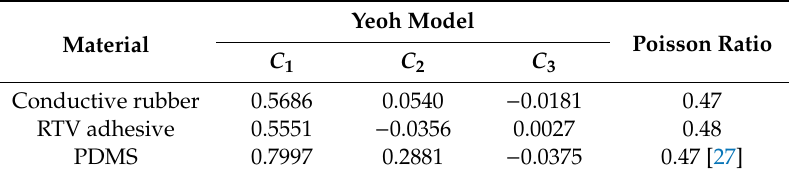
Table 1. Material properties of rubber, RTV, and PDMS materials.